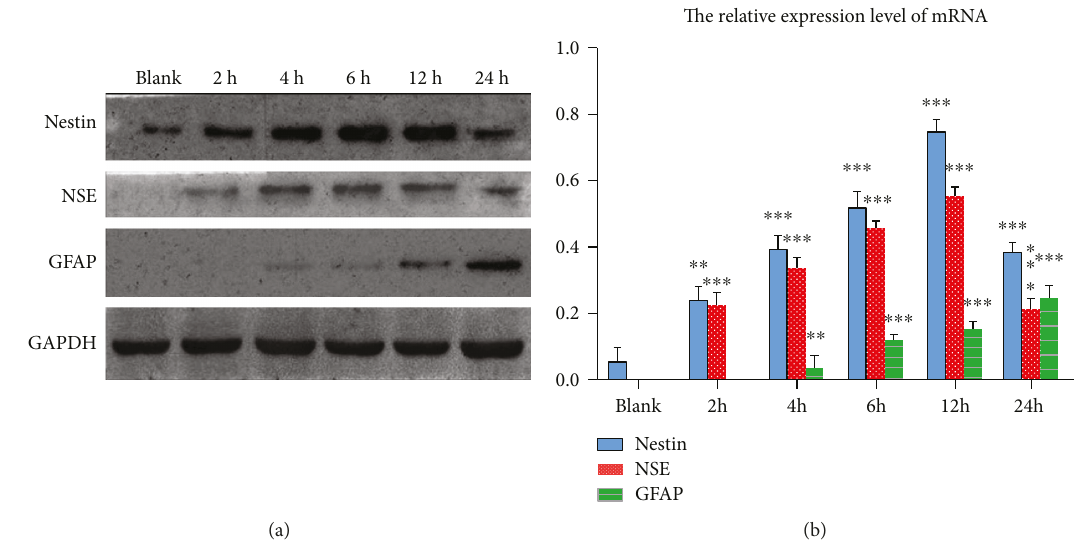
Figure 8: (a) Result of Western blot. (b) Relative expression level of